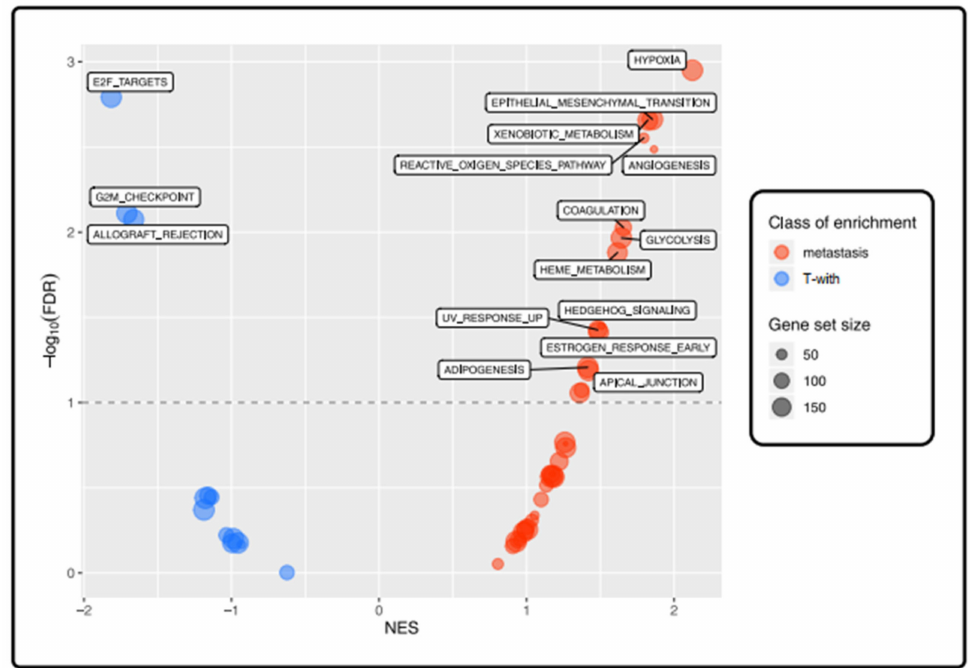
Figure 6. Di ff erently enriched pathways in T-with compared to paired DM samples: GSEA Hallmark analysis. Bubble plot showing the enrichment Hallmark gene sets between the T-with and DM groups. Every bubble represents a gene set; the bigger the size of the bubble, the higher the number of genes in the gene set. Red bubbles are gene sets which are more enriched in the metastasis group (NES > 0), whereas blue bubbles represent those enriched in the primary tumor (PT) samples (NES < 0). We considered as significantly enriched those gene sets having an FDR less than 0.1 (10%) and labeled those having a NES >